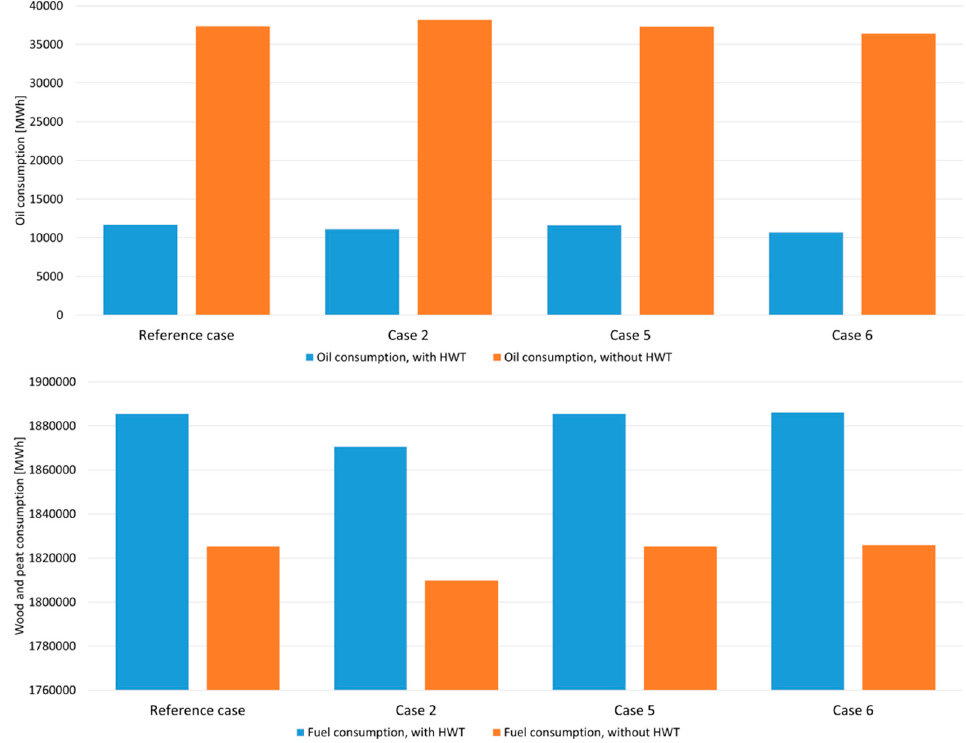
Figure 7. Fuel consumption in the reference case and in Cases 2, 5 and 6.